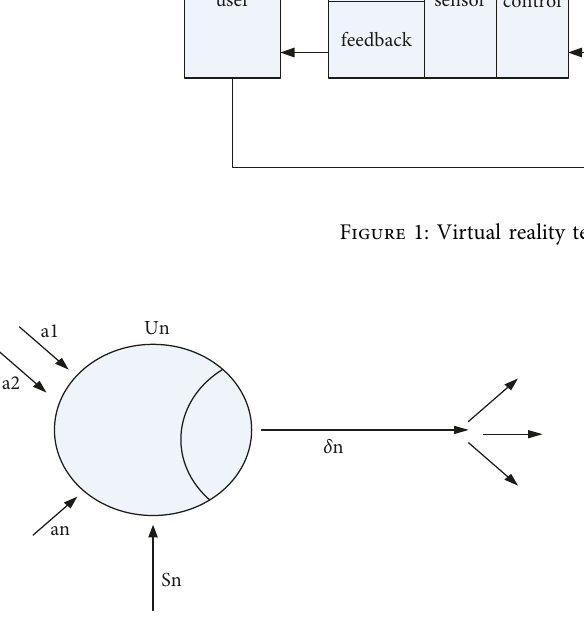
Figure 2: Structure diagram of artificial neuron